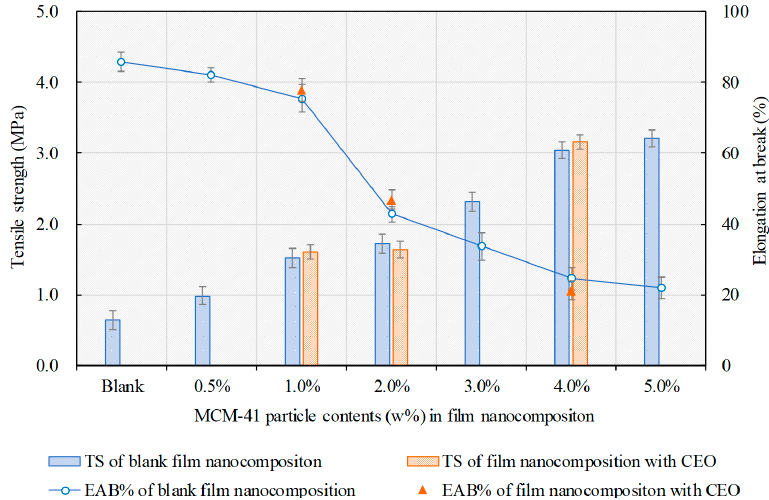
Figure 4. Tensile strength (TS, bars) and elongation at break (EAB%, dots and line) of the film nanocomposite with different MCM-41 particle contents.